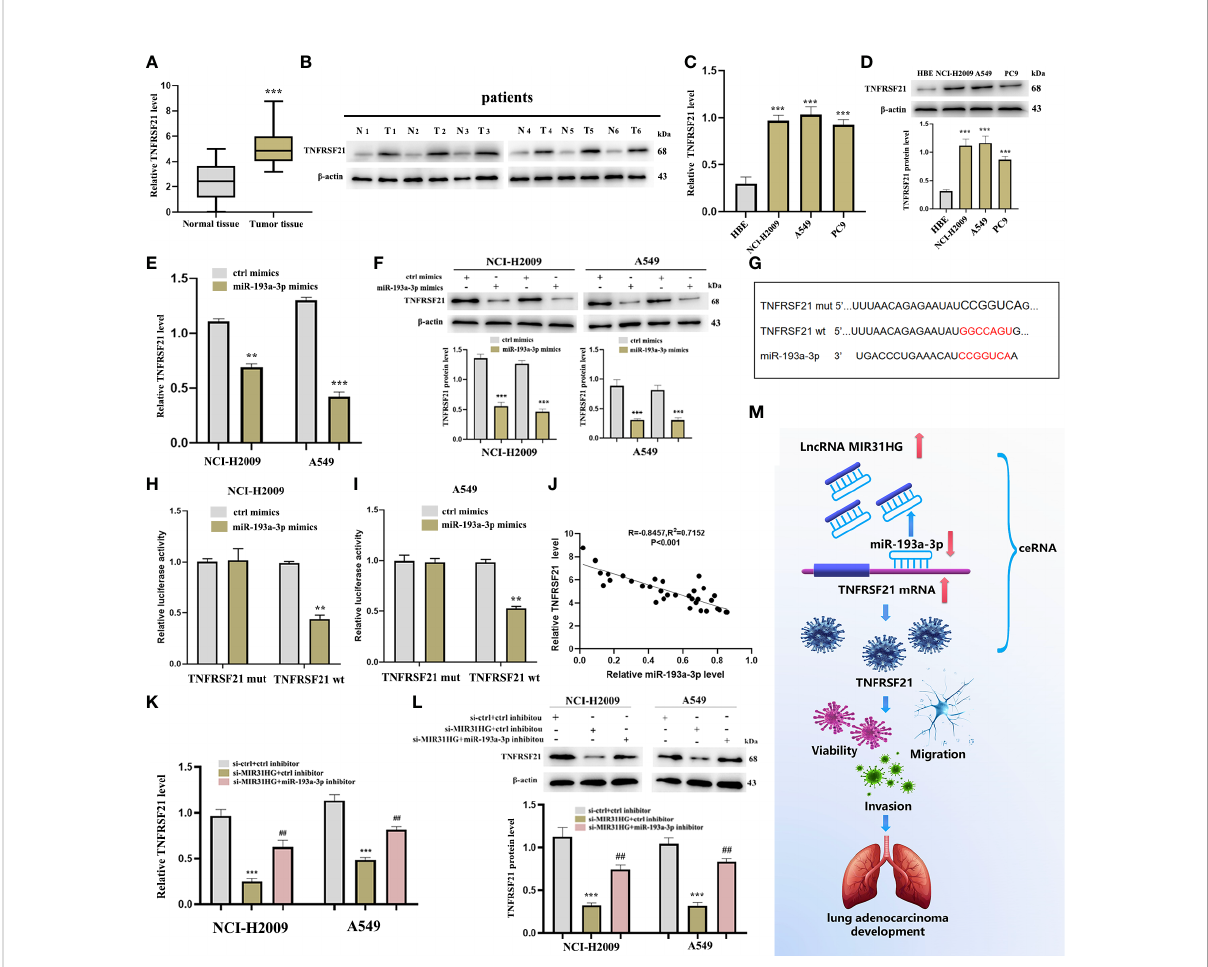
FIGURE 11 TNFRSF21 was a downstream target of miR-193a-3 and lncRNA MIR31HG sponged miR-193a-3p to upregulate TNFRSF21. (A) TNFRSF21 expression in lung adenocarcinoma (LUAD) specimens compared with normal tissues as detected by qRT-PCR. *** p < 0.001 vs . normal tissue. (B) TNFRSF21 expression in 6 LUAD patients relative to normal tissues as detected by western blot. (C, D) TNFRSF21 expression in different LUAD cell lines (A549, NCI-H2009, and PC9) relative to bronchial epithelioid cell (HBE) was estimated by qRT-PCR or western blot. *** p < 0.001 vs . HBE. (E, F) TNFRSF21 expression following miR-193a-3p overexpression was assessed by qRT-PCR or western blot. ** p < 0.01; *** p < 0.001 vs . ctrl mimics. (G) Schematic diagram of the predicted interacting sites. (H, I) The relationship between TNFRSF21 and miR-193a-3p in NCI- H2009 and A549 cells was performed by dual-luciferase reporter assay. ** p < 0.01 vs . ctrl mimics. (J) Relationship between TNFRSF21 and miR- 193a-3p investigated by Pearson ’ s analysis. (K, L) TNFRSF21 expression following si-MIR31HG or si-MIR31HG + miR-193a-3p inhibitor was assessed by qRT-PCR or western blot. *** p < 0.001 vs . ctrl inhibitor; ## p < 0.01 vs . si-MIR31HG + miR-193a-3p inhibitor. (M) Schematic diagram of the mechanism of lncRNA MIR31HG/miR-193a-3/TNFRSF21 regulatory